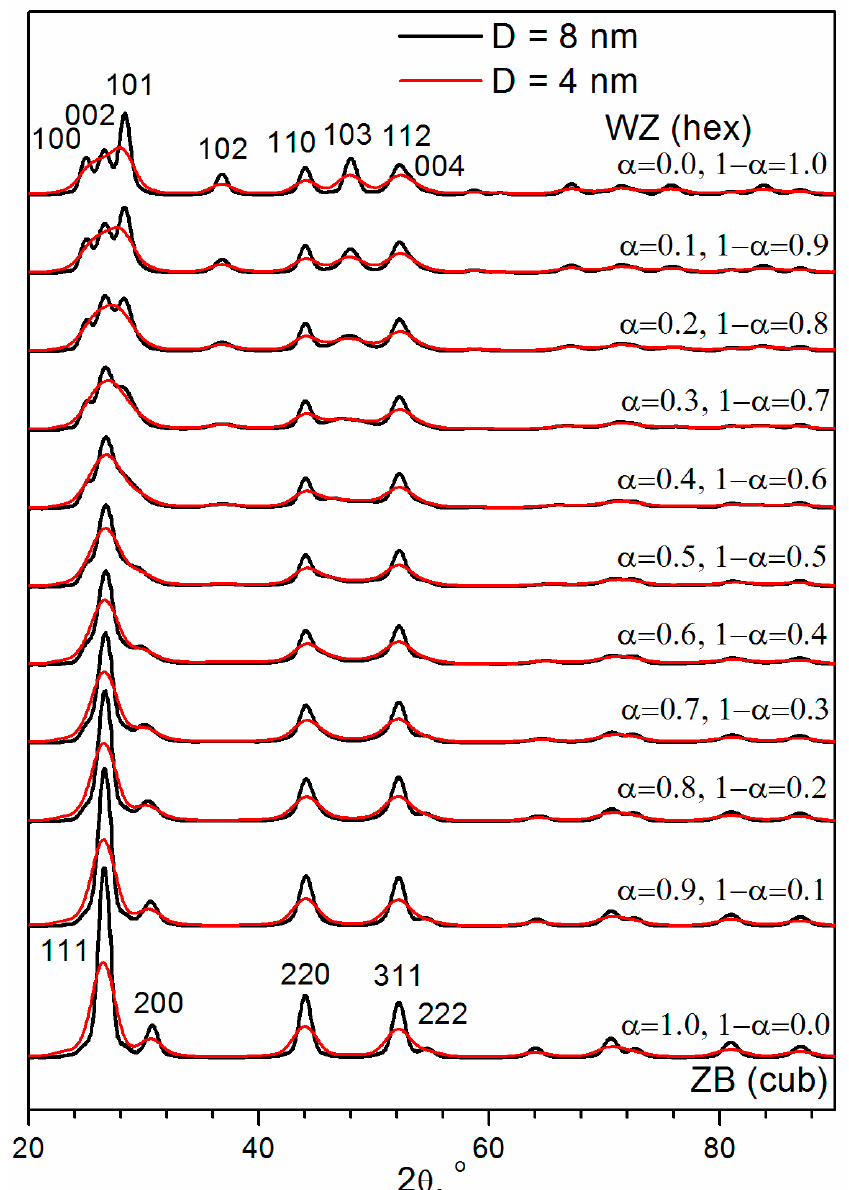
Figure 4. Debye simulation of XRD patterns for spherical CdS nanoparticles having different diameters D and containing different probability of SFs in WZ structure ( α ) or in ZB structure (1 − α ).